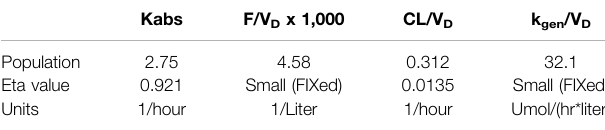
TABLE 6 | Population fi t parameters from NONMEM. Kabs F/V D x 1,000 CL/V D k gen /V